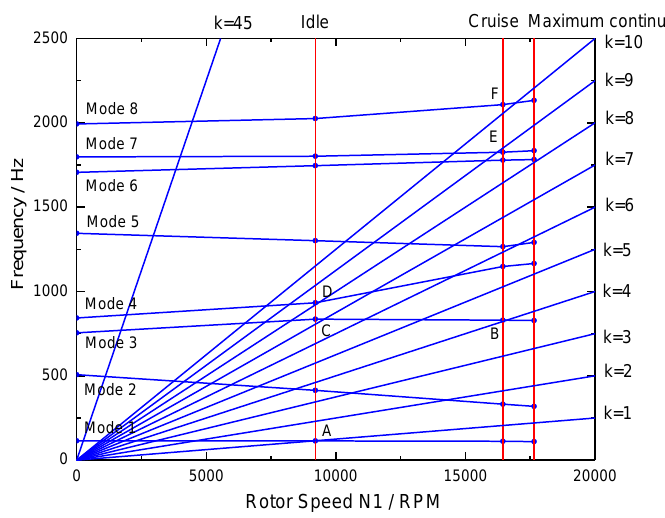
Figure 2. Typical Campbell diagram of a high pressure turbine blade showing selected crossings.